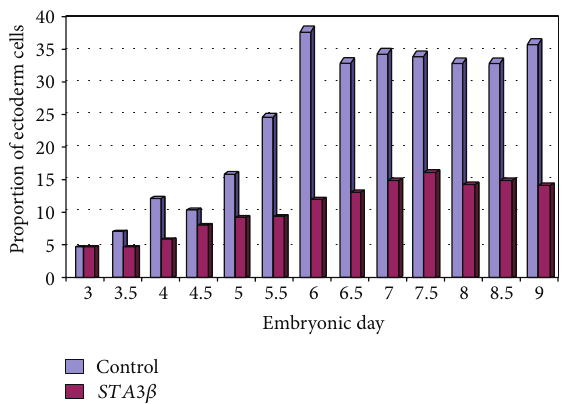
Figure 7: Possible outcome for control versus STAT3 𝛽 comparison. We predict that STAT3 𝛽 will reduce ectodermal